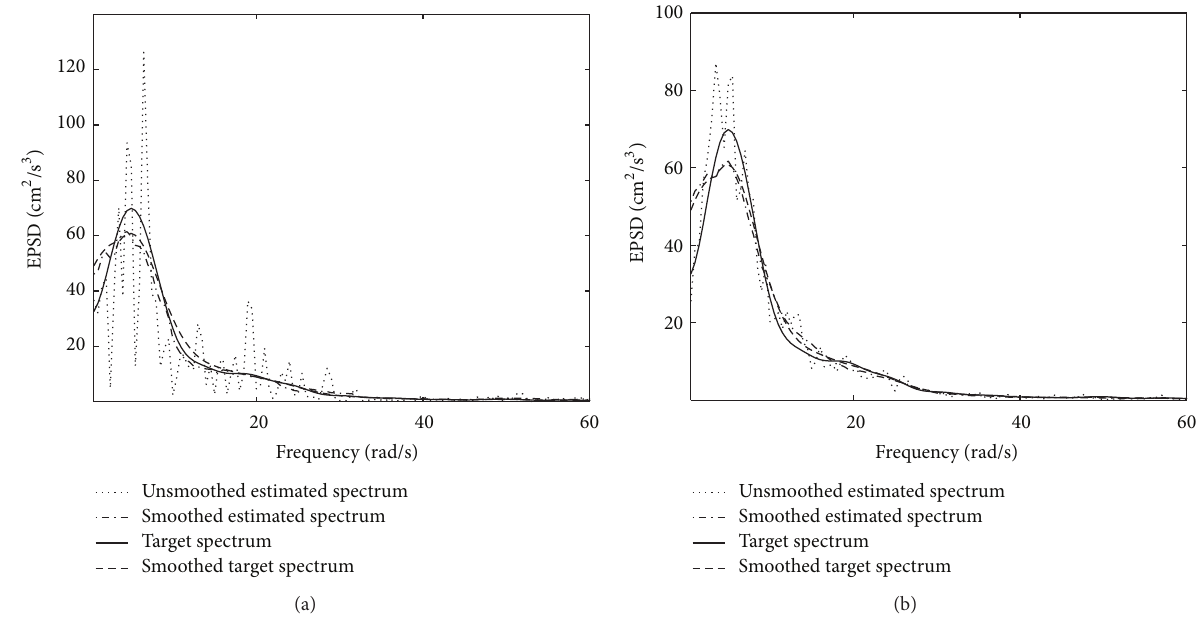
̂𝑆 (𝜔,𝑡) , 𝑆 0 (𝜔,𝑡) , and 𝑆 0 (𝜔,𝑡) ), at the time instant t = 2.0 s: (a) from one set of sample 12 12 12